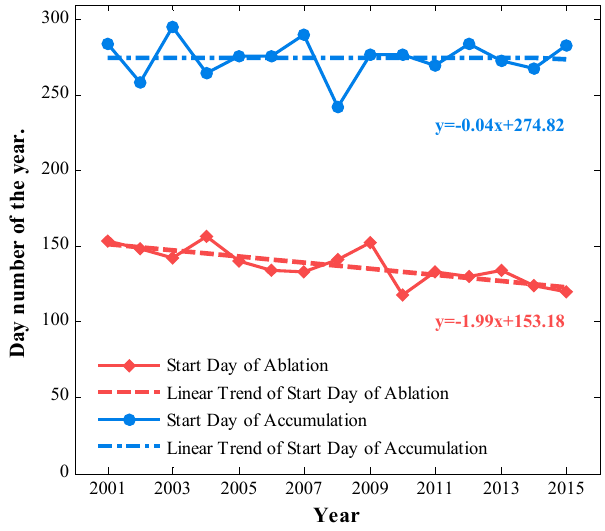
Figure 10. Start days of snow accumulation and ablation at the 37 ground stations during 2001–2015 based on the criteria (see the text) applied to the eight-day moving average data of the numbers of daily snow stations.